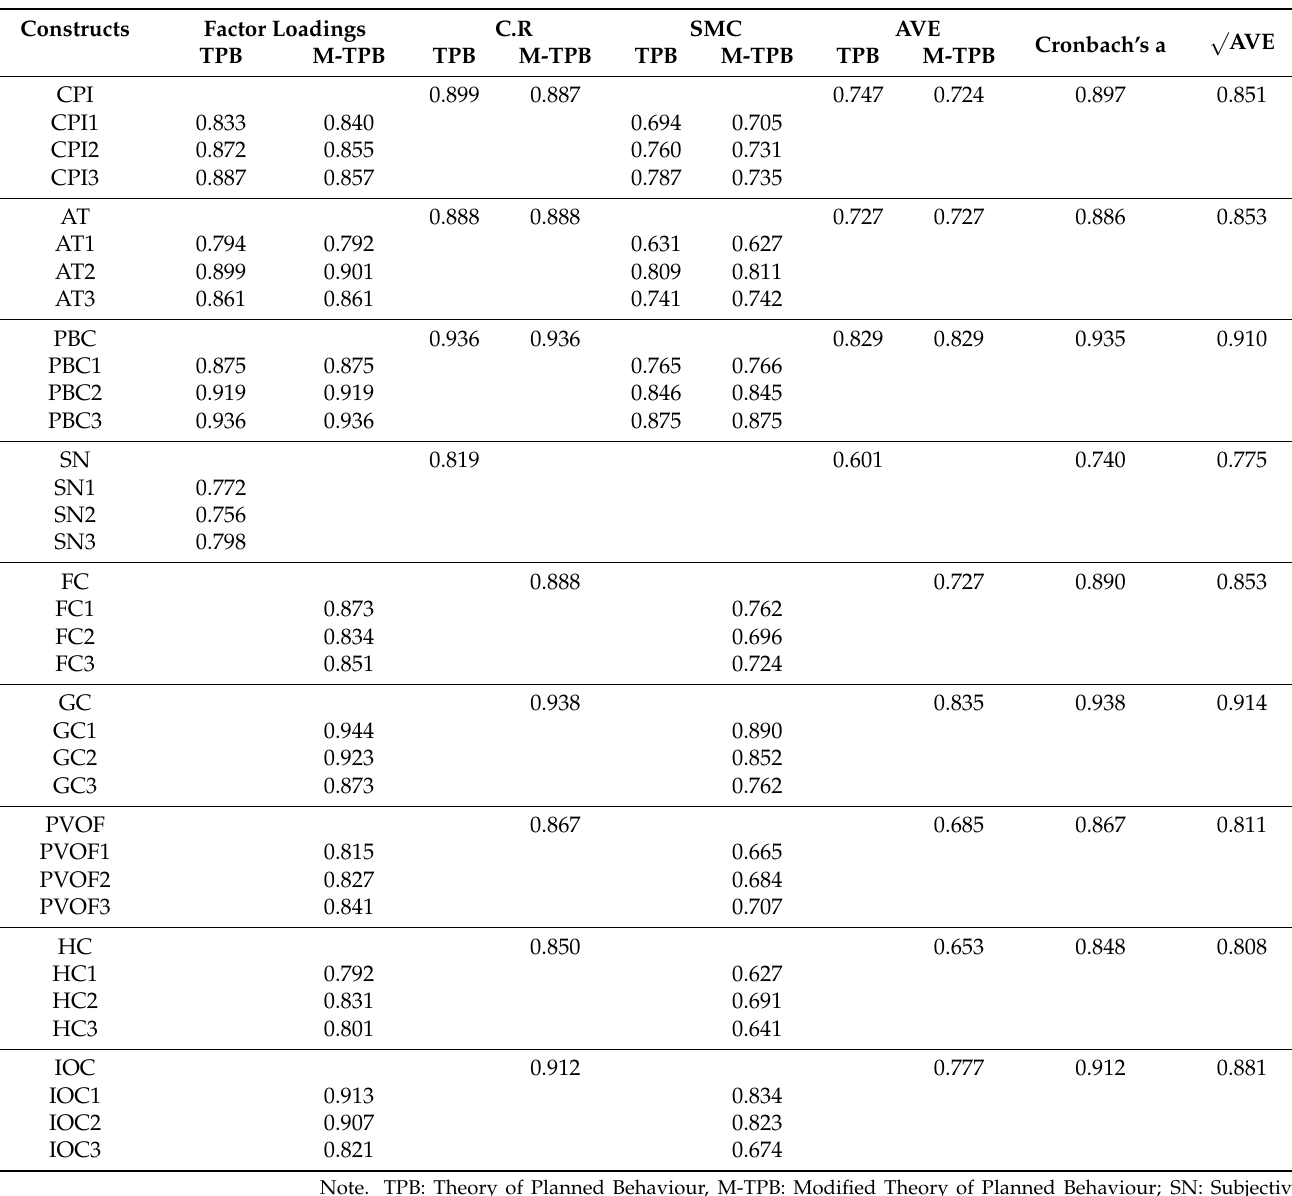
Table 3. Measurement model: Reliability and